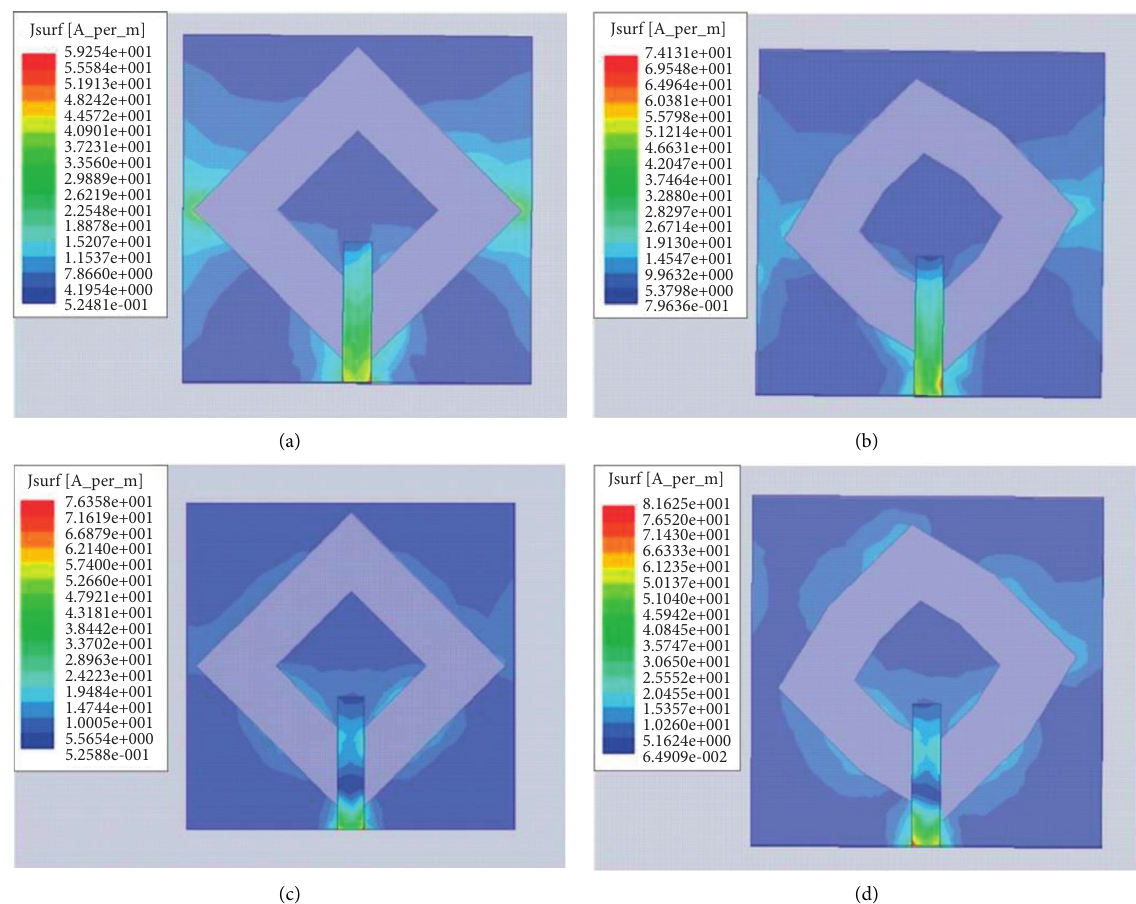
Figure 8: Surface current distribution of antenna. (a) Original antenna at 2.7GHz, (b) final antenna at 2.7GHz, (c) original antenna at 5.76GHz, and (d) final antenna at 5.76